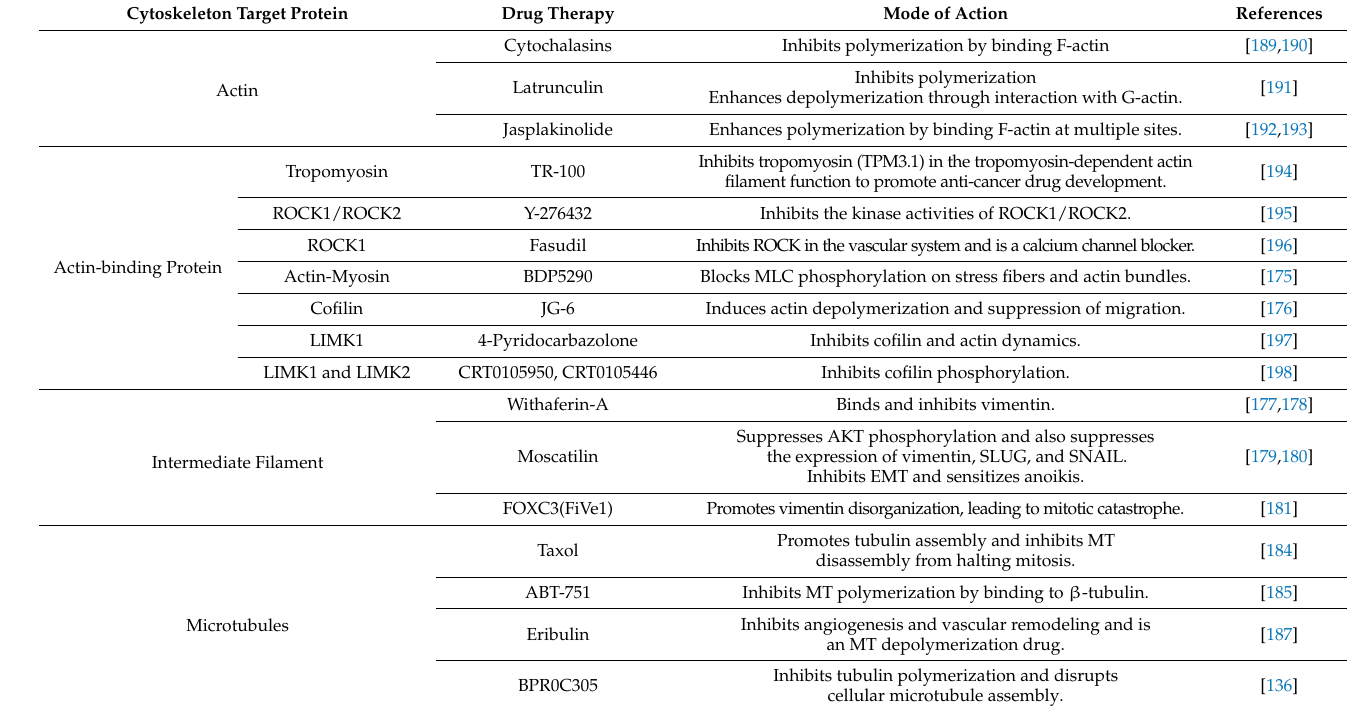
Table 2. Examples of various drugs targeting cytoskeletal molecules and their action mechanism. Cytoskeleton Target